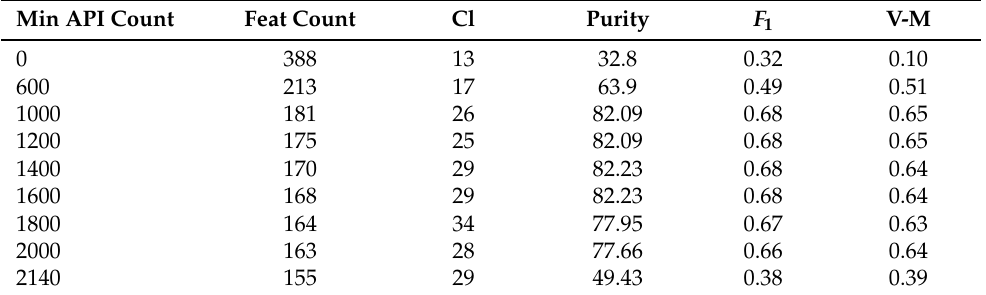
Table 2. Data Set 1C exclusion of infrequent features.